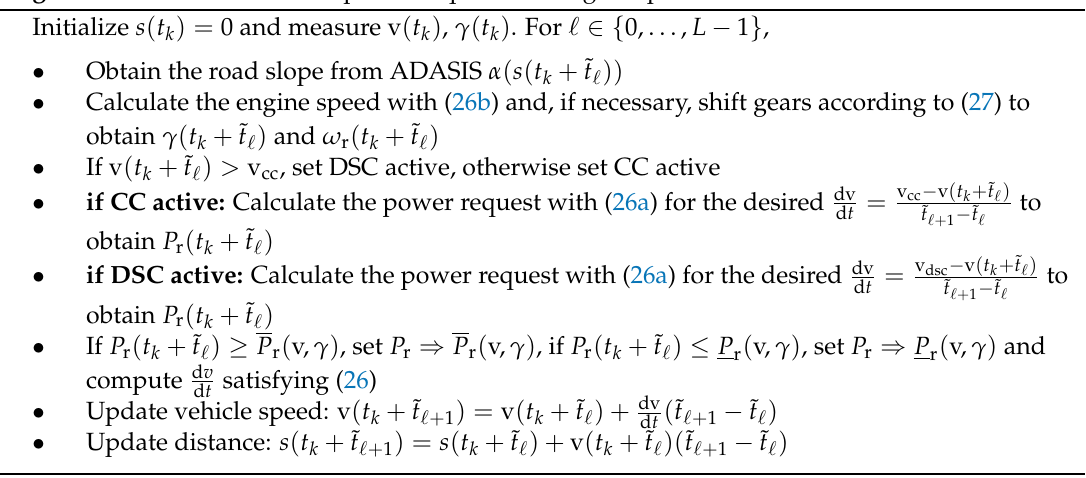
Algorithm 2: Prediction of the power request and engine